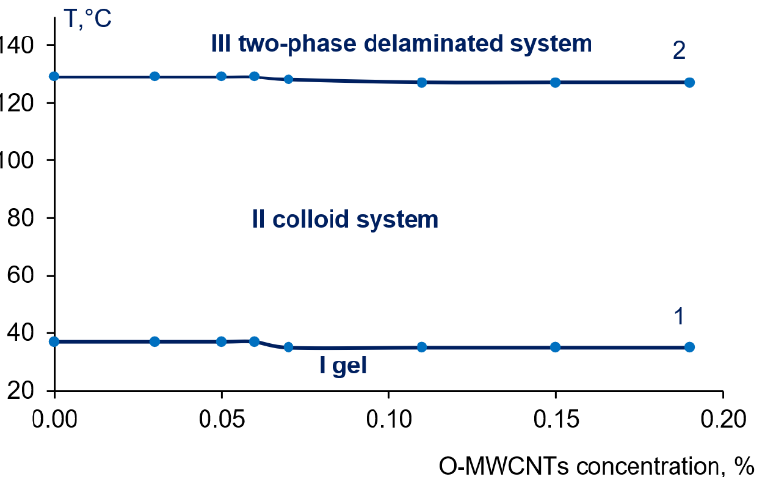
Figure 4. Dependence of gel point (1) and demixing temperature (2) of the system containing 15 wt.% PPSU–15 wt.% PEG 20,000–0.5 wt.% PVP K30–0-0.19 wt.% O-MWCNTs in NMP: I—gel region, II—region of colloid system, III—region of the two-phase delaminated system.